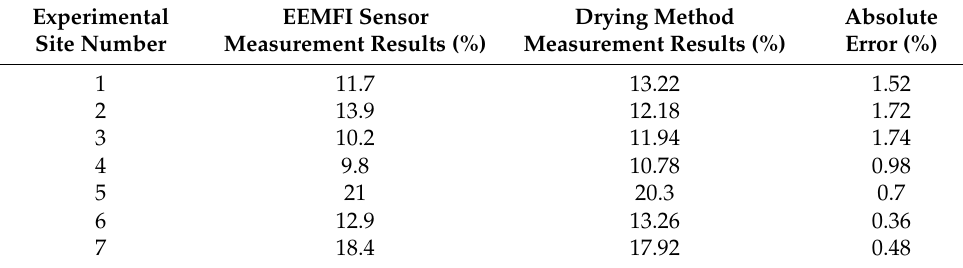
Table 7. Comparison of measurement results between EEMFI sensor and drying method.